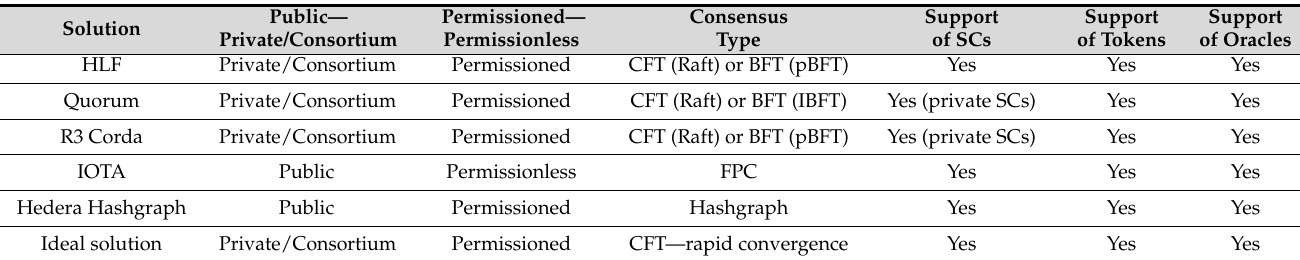
Table 2. Suitability of the examined blockchain and DAG